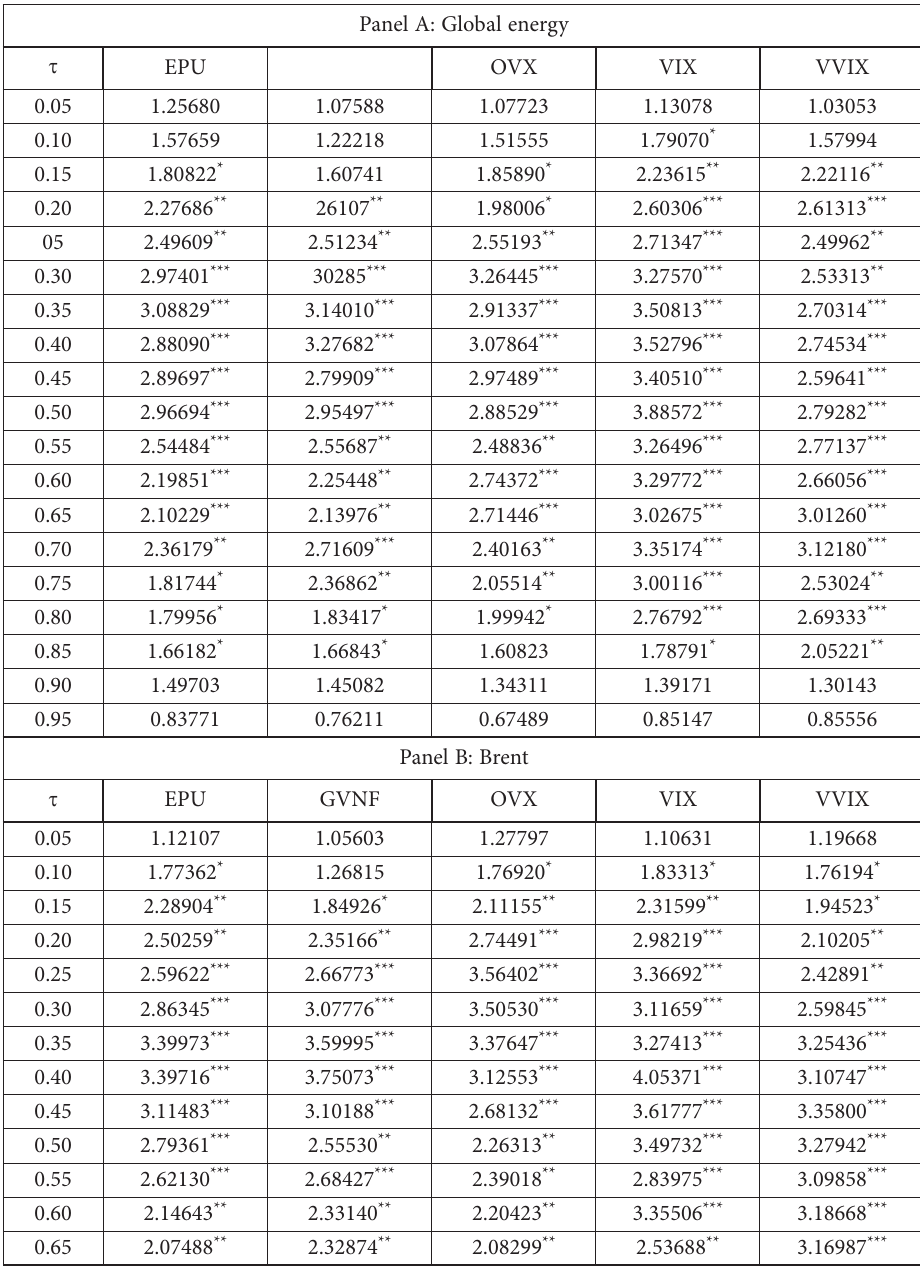
Table 3. T-statistics from causality-in-quantiles tests